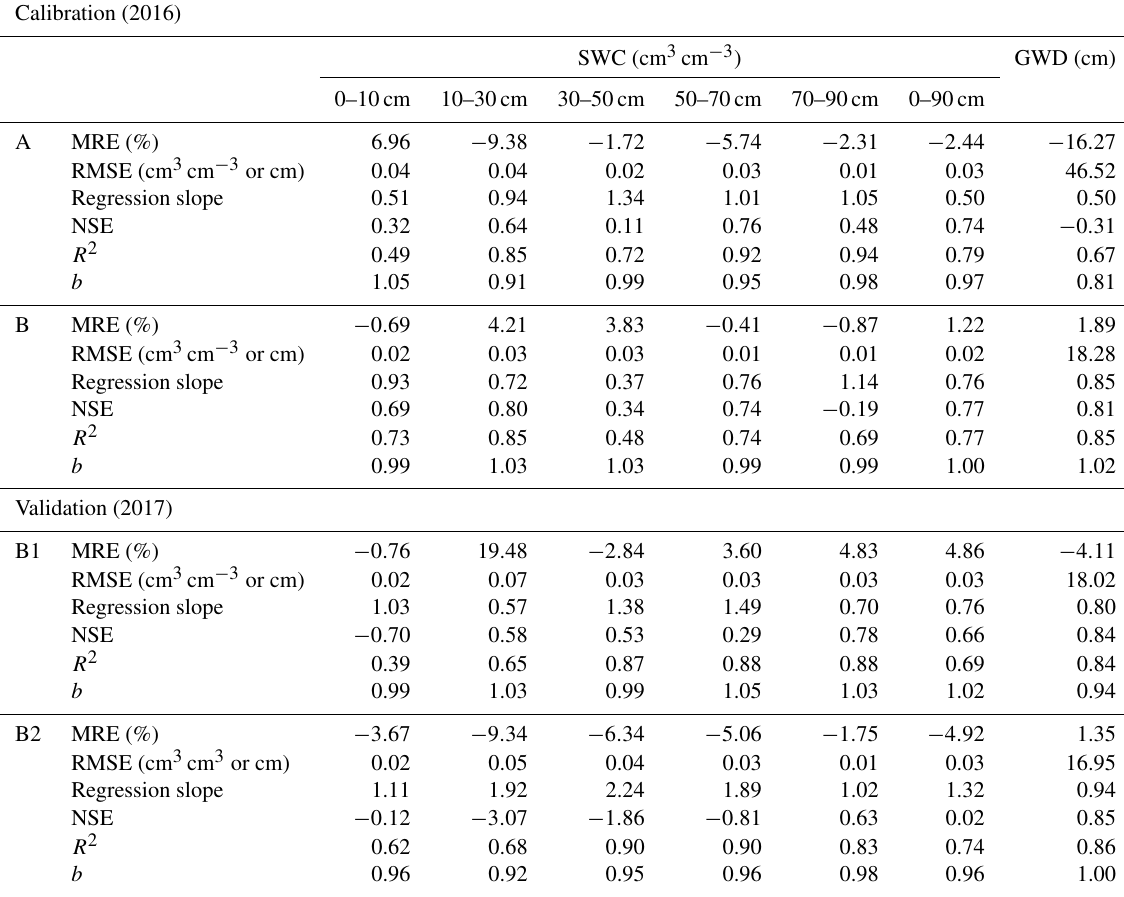
Table 7. Model statistics for calibration of the shallow aquifer model in 2016. The mean relative error (MRE), root-mean-square error (RMSE), regression slope, coefficient of determination ( R 2 ) and regression coefficient ( b ) are listed. Note: SWC is the soil water content, and GWD is the groundwater